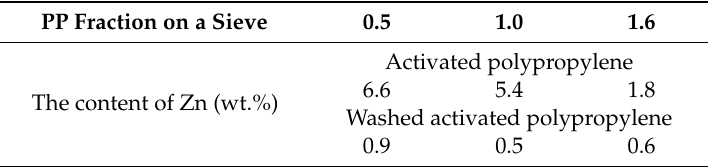
Table 3. The content of the activator metal on the polypropylene surface.